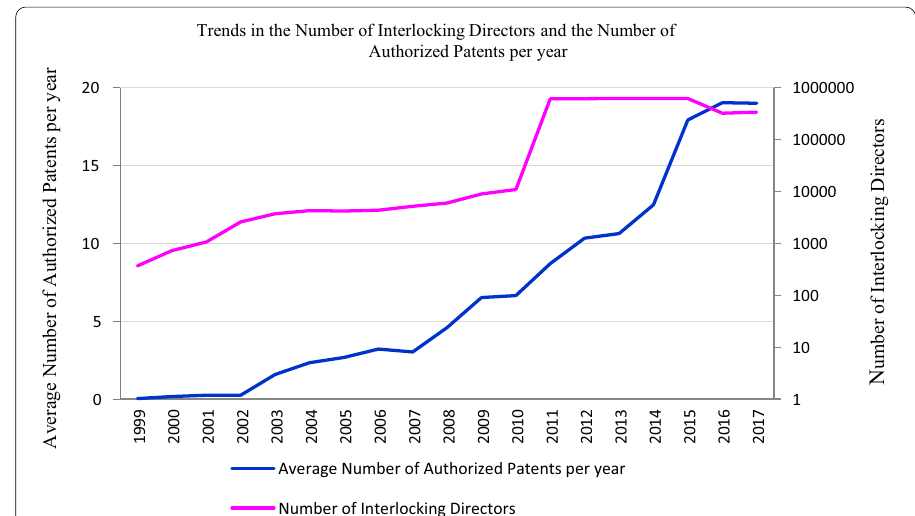
Fig. 1 Trends in the Number of Interlocking Directors and the Number of Authorized Patents per year. Noted : The figure plots trends in the number of interlocking directors and the number of authorized patents in China. The blue line shows the average number of patents authorized per A‑share listed firm in China each year, and the red line shows the number of interlocking directors with part‑time jobs at two or more firms